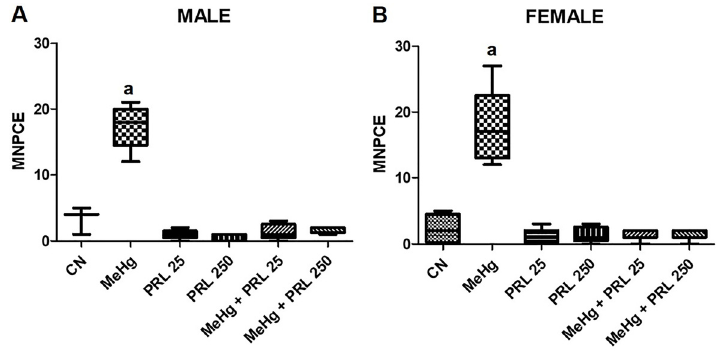
Figure 8. Frequency of micronucleated polychromatic erythrocytes (MNPCE) in each treatment group for males ( A ) and females ( B ). Data are reported as medians and interquartile range. a P o 0.01 compared to all other treatments (ANOVA with Tukey ’ s post-test). CN: control group; MeHg: methylmercury; PRL 25 and PRL 250: 25 and 250 m g/kg prolactin, respectively, every 12 h.